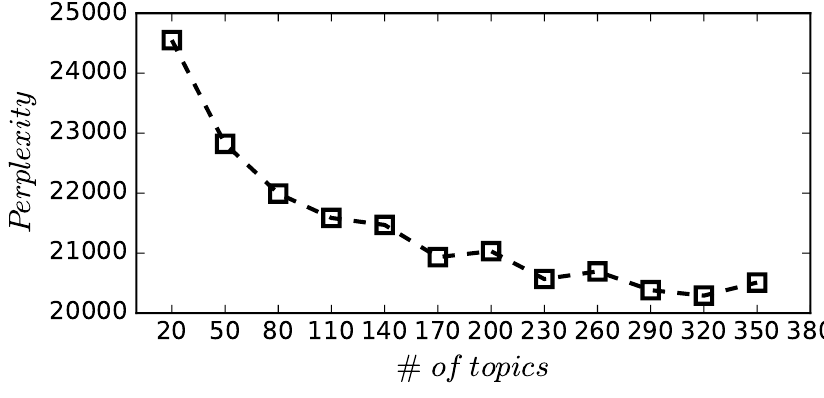
Figure 4. Perplexity